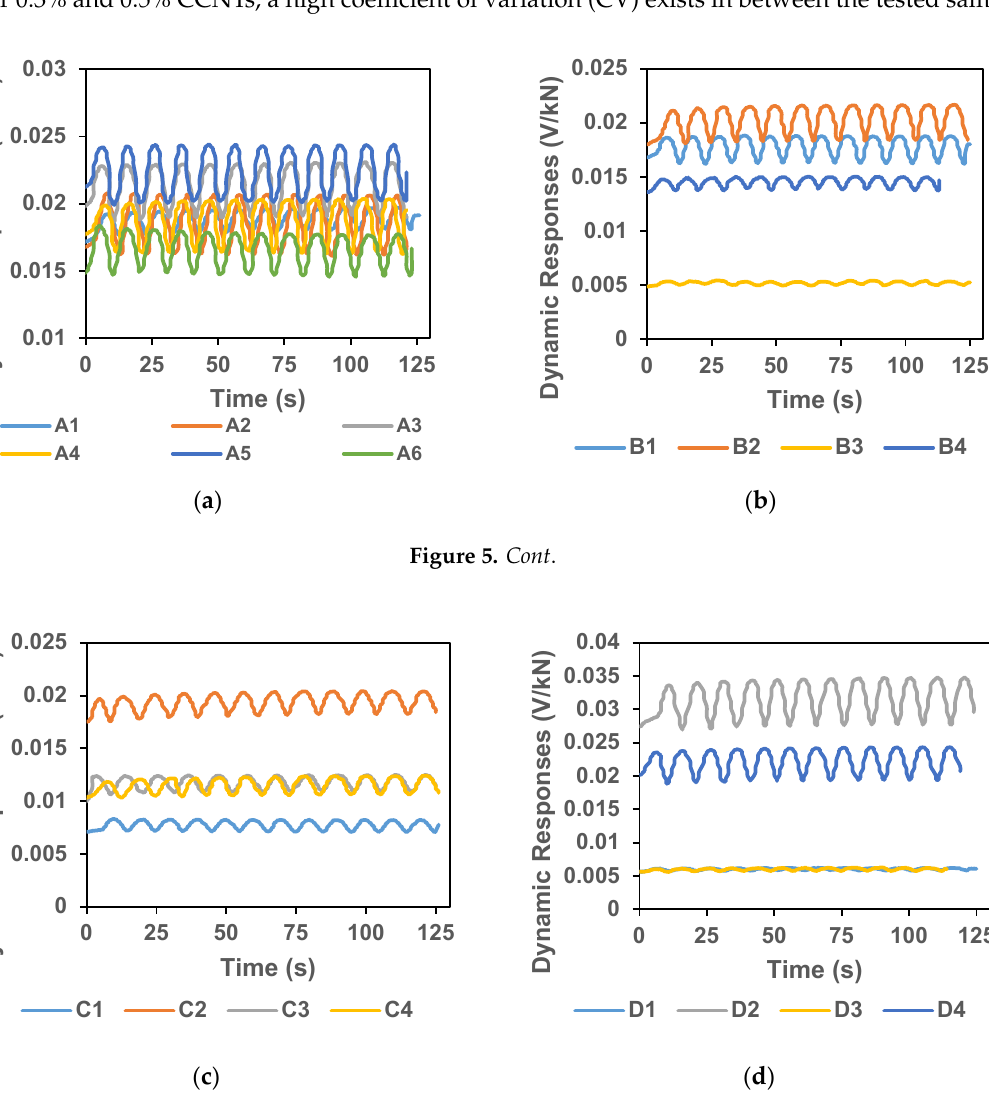
Figure 5. Dynamic load responses in sample blocks impregnated with 0.1% CCNTs ( a ), 0.2% CCNTs ( b ), 03% CCNTs ( c ) and 0.5% CCNTs ( d ). The multiple plots represent responses from each sample from Group B.